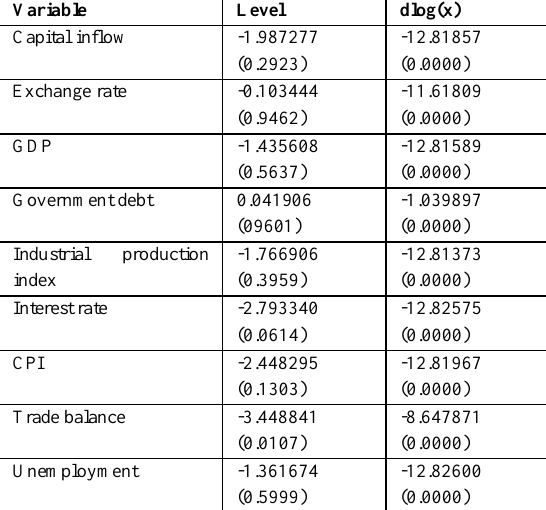
Table 1: The Stacionarity (Augmented